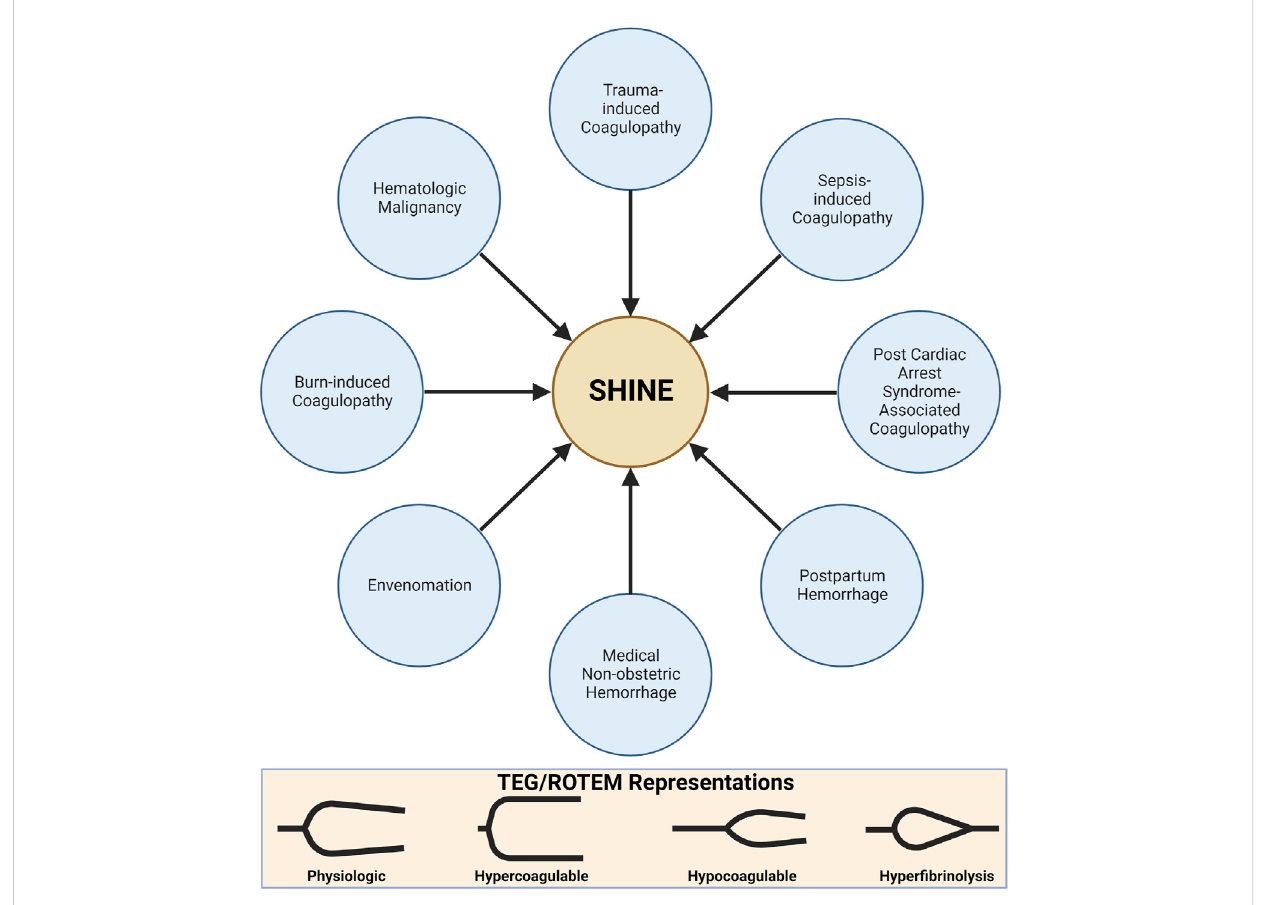
FIGURE 5 SHock-INduced Endotheliopathy (SHINE) as a Unifying Mechanism for Coagulopathies Associated with Critical Illness. In this review, we contextualize SHINE as de fi ned by the viscoelastic hemostatic assays thromboelastography (TEG) and rotational thromboelastometry (ROTEM) within many causes of shock. Created with